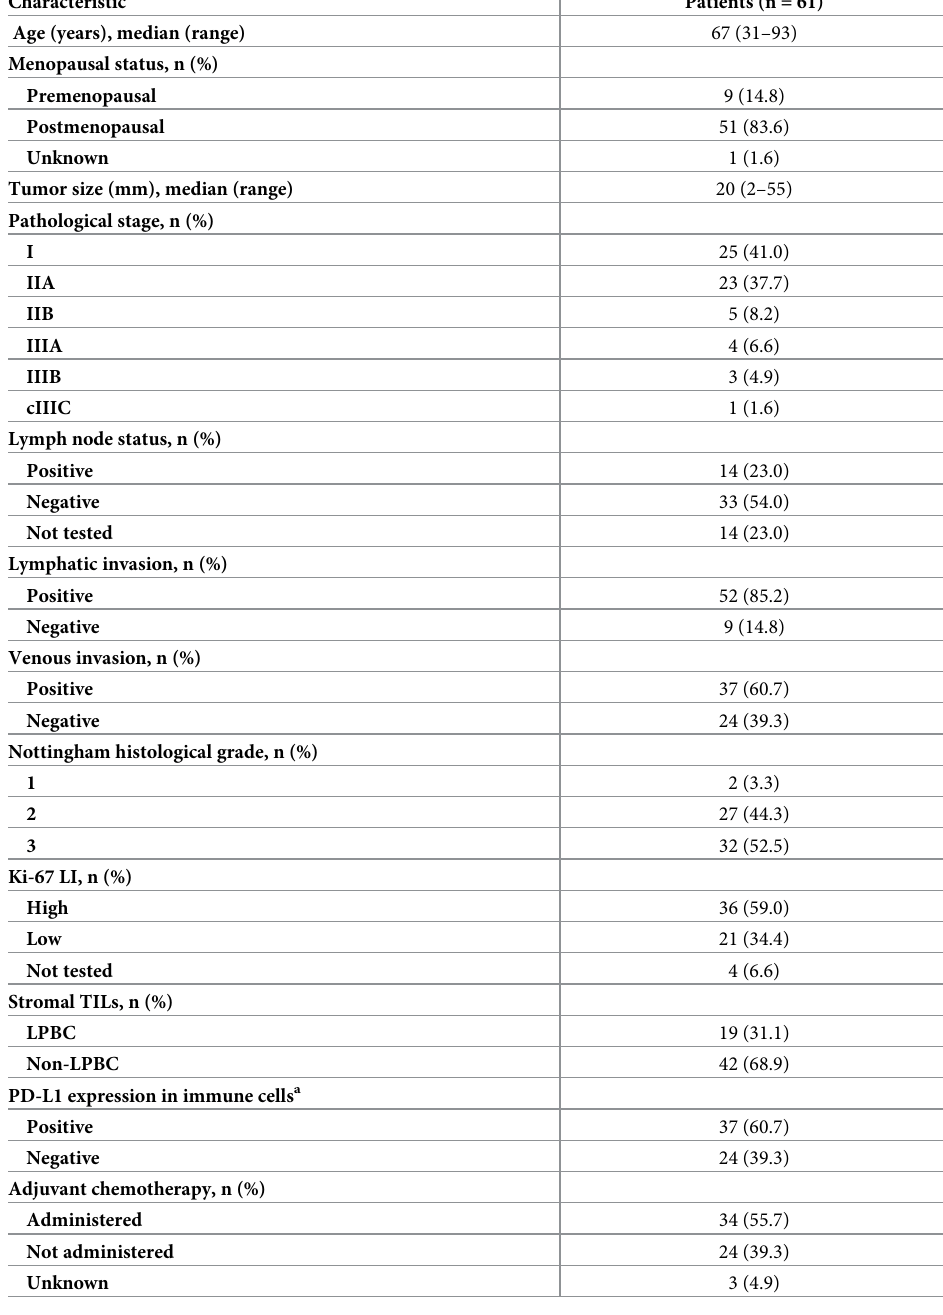
Table 1. Clinical characteristics of patients with triple-negative breast